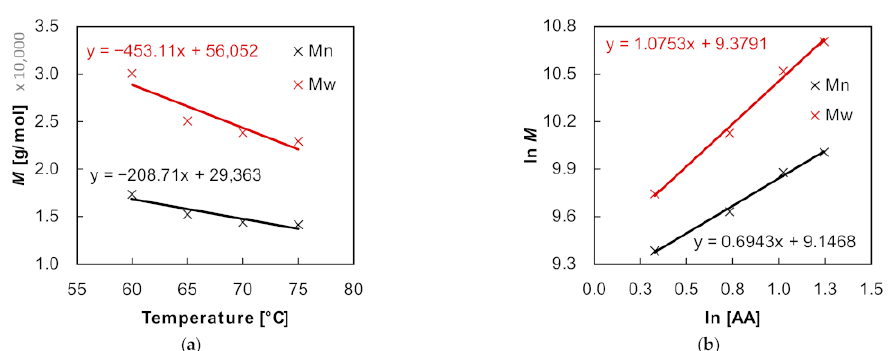
Figure 13. ( a ) Effect of temperature on the number- and weight-average molecular weight during the polymerisation of acrylic acid in 2-propanol (150 g/L, 1 mol% AIBN). ( b ) Corresponding influence of the initial monomer concentration at a constant reaction temperature of 65 ◦ C. Molecular weights were determined after a conversion of about